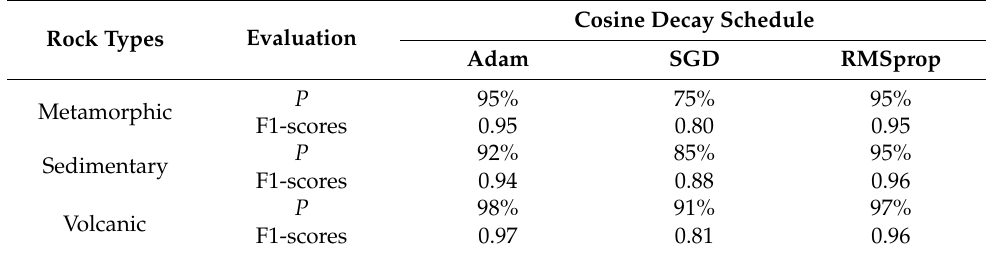
Table 8. Detailed classification results for all rock types.